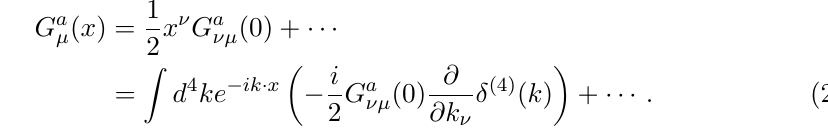
on it. In the below argument, we take gauge dependence parameter x 0 as x 0 = 0 for